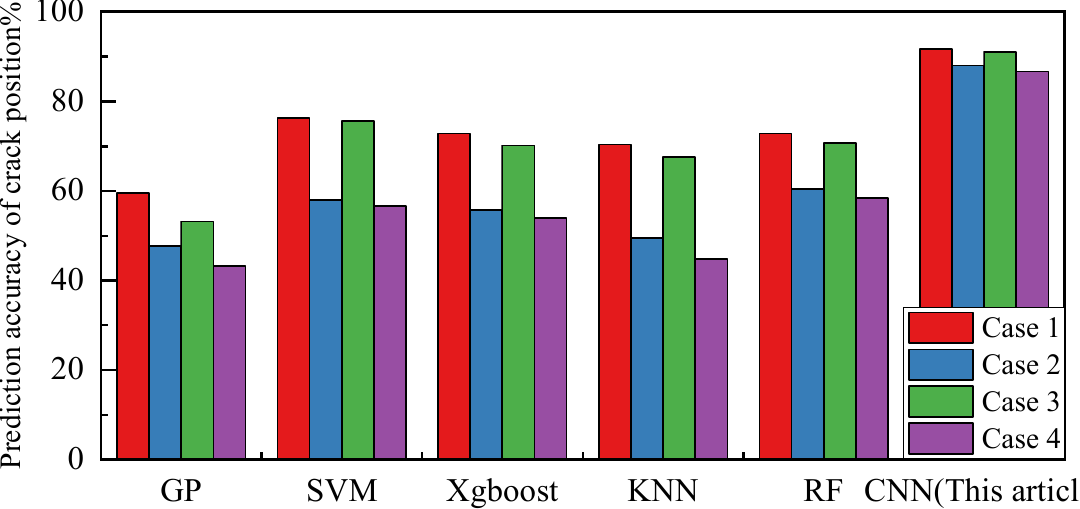
Figure 7. Prediction accuracy of blade crack location by different deep learning models (case 1: No system deviation and No noise; case 2: System deviation and No noise; case 3: Noise and No system deviation; case 4: System deviation and Noise).